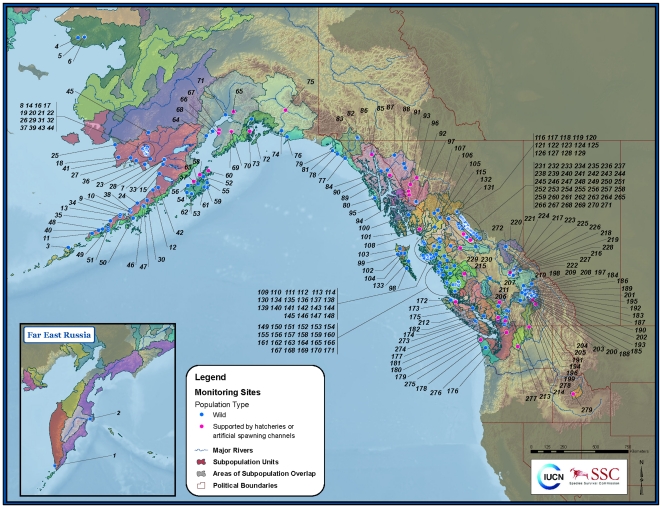
Escapement monitoring sites for sockeye salmon.Escapement monitoring sites for sockeye salmon throughout their natural range in the North Pacific. These sites (N = 279) yielded escapement records spanning at least three generations, or 12 years. Numbers displayed on map correspond to identification numbers for monitoring sites in Tables S1 and S2.